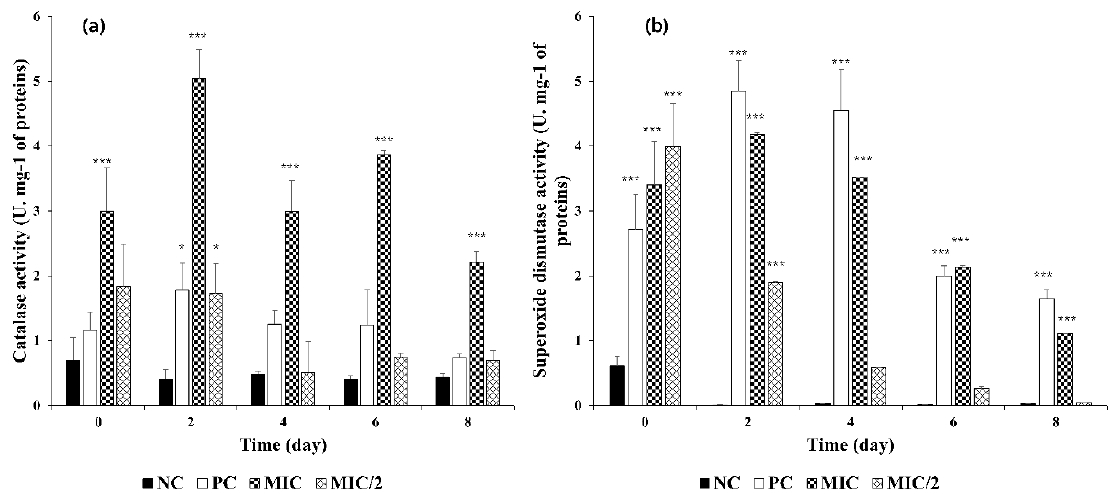
Figure 4. Effect of R. aquatilis aqueous extracts on the M. aeruginosa enzymatic activities. ( a ) catalase activity and ( b ) superoxide dismutase activity. Each value is the mean ± SD of three replicates. * p < 0.05 and *** p < 0.001 indicate significant differences compared to the untreated culture.